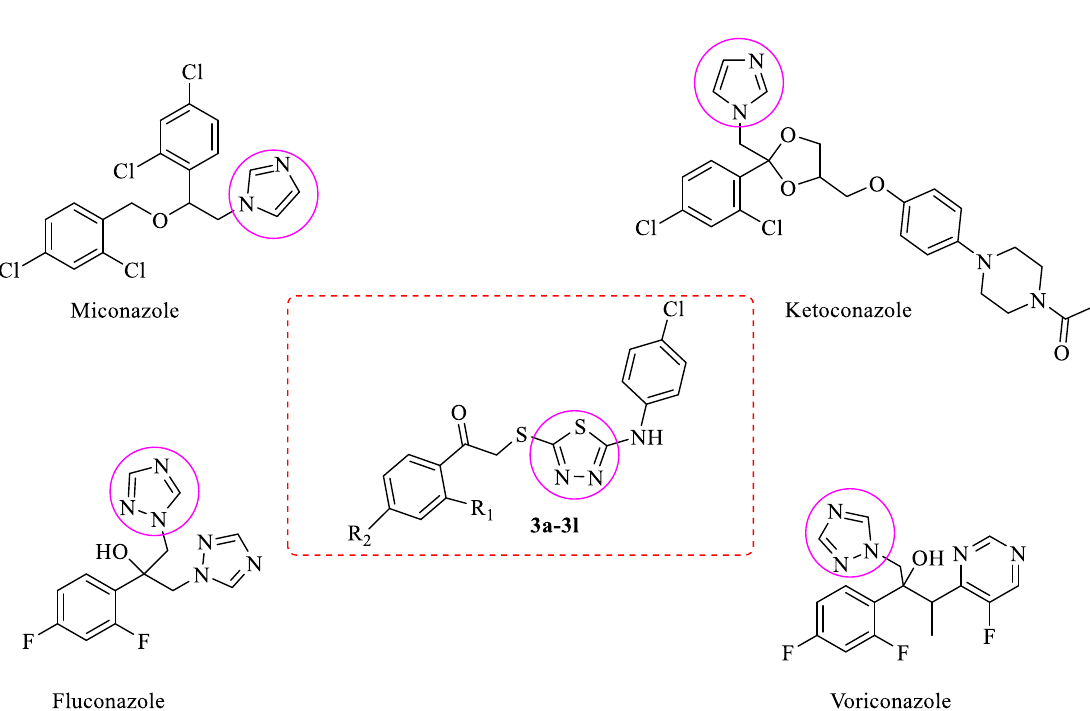
Figure 1. Chemical structures of targeted compounds and some antifungal drugs which are in clinical use.